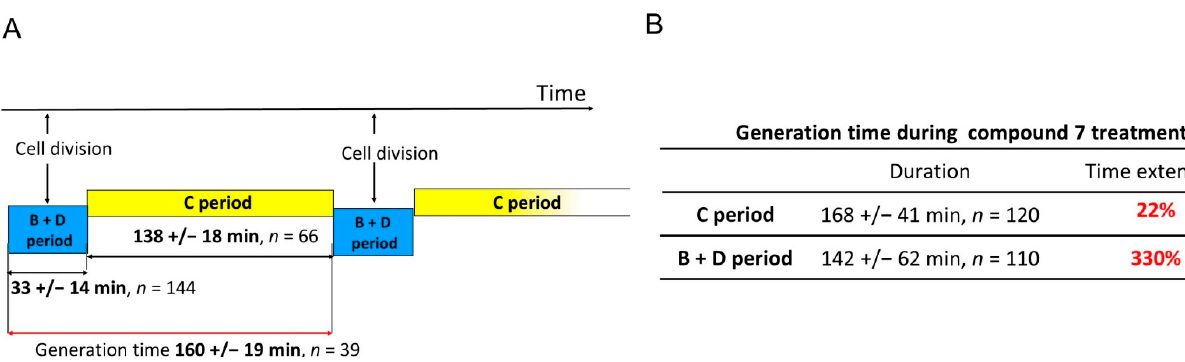
Figure 9. The duration of the C and the B + D periods during the cell cycle of M. smegmatis expressing DnaN-EGFP protein fusion (JH01 strain) measured under optimal growth conditions ( A ) and when treated with compound 7 ( B ).